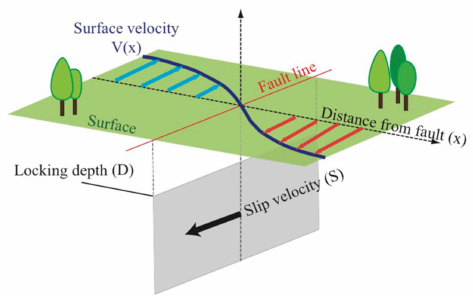
Figure 3. Illustration presenting the elastic dislocation model connecting the surface deformation V(x) to the locking depth (D) as well as the slip velocity at depth (S), which is illustrated here in the case of a dextral strike-slip